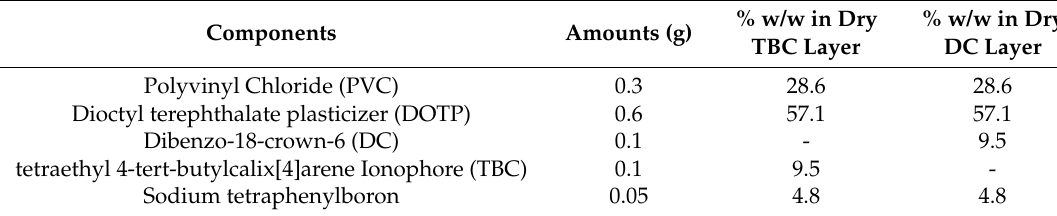
Table 2. Composition of the coating layer.